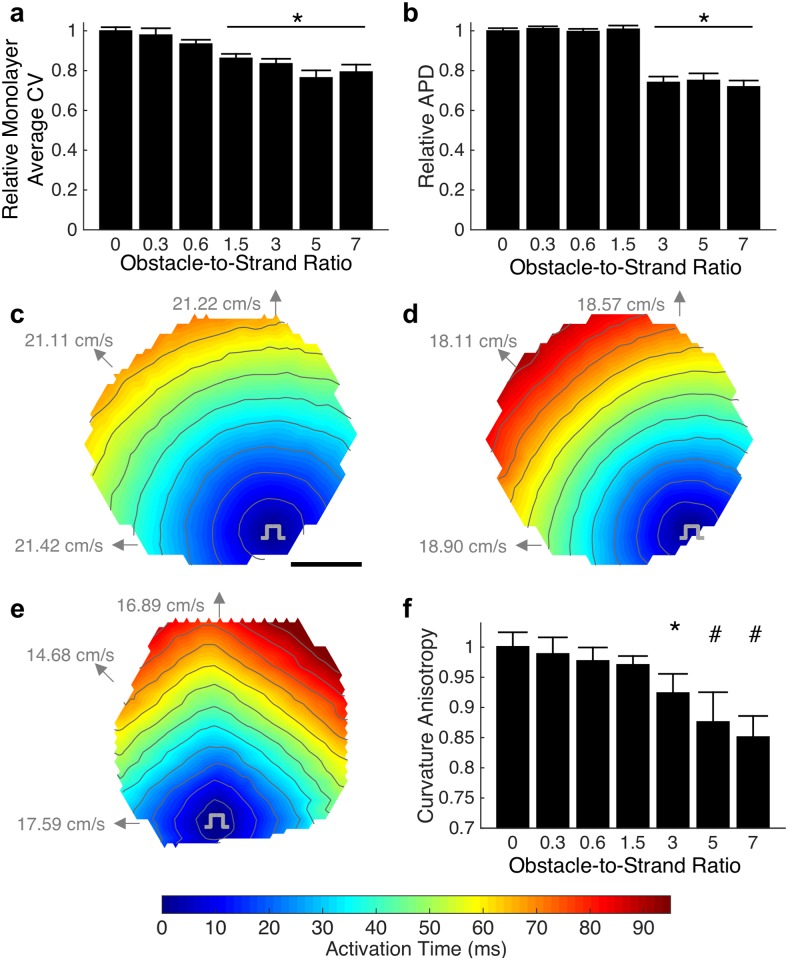
Effects of microscopic heterogeneity on macroscopic conduction.(a) Increasing degree of heterogeneity, as characterized by the obstacle width to strand width ratio, leads to slowing of macroscopic conduction (mean ± se; n = 13–68 monolayers; F(6,217) = 11.53. p < 0.0001; Asterisk indicates significant difference from homogenous case, p < 0.05; values represent average CV across each individual monolayer). (b). Shortening of action potential duration is observed at high obstacle-to-strand ratios (mean ± se; F(6, 217) = 42.7. p < 0.001). (c-e) Macroscopic activation maps becomes increasingly anisotropic as obstacle-to-strand ratio increases from 0 (c) to 1.5 (d) to 7.0 (e). Directional conduction velocities are as indicated. Average conduction velocities across these representative monolayers are 21.28 cm/s (c), 18.56 cm/s (d) and 16.79 cm/s (e). Scale bar = 5 mm; Activation isochrone lines at 8 ms spacing. (f) Quantified anisotropy of 1 indicates isotropic conduction while √2/2 indicates a diamond shape isochrone (mean ± sd; n = 10–15 monolayers; F(6,72) = 42.5. p < 0.001; * and # indicate significant difference from all lower obstacle-to-strand ratios, p < 0.05).